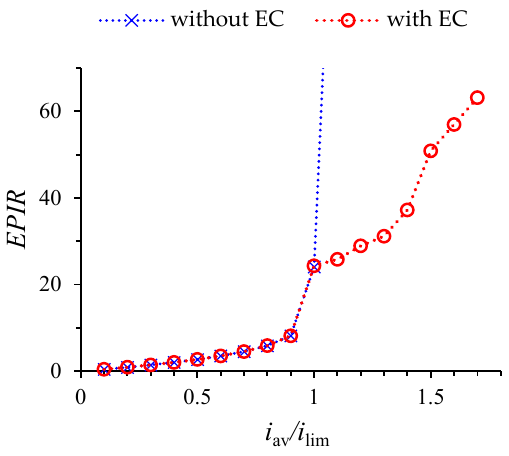
Figure 6. Energy per ion removal in a quasi-stationary state, calculated with and without taking into account the development of electroconvection (EC) for the following values of current density i av / i lim : 0, 0.1, …, 1.7.